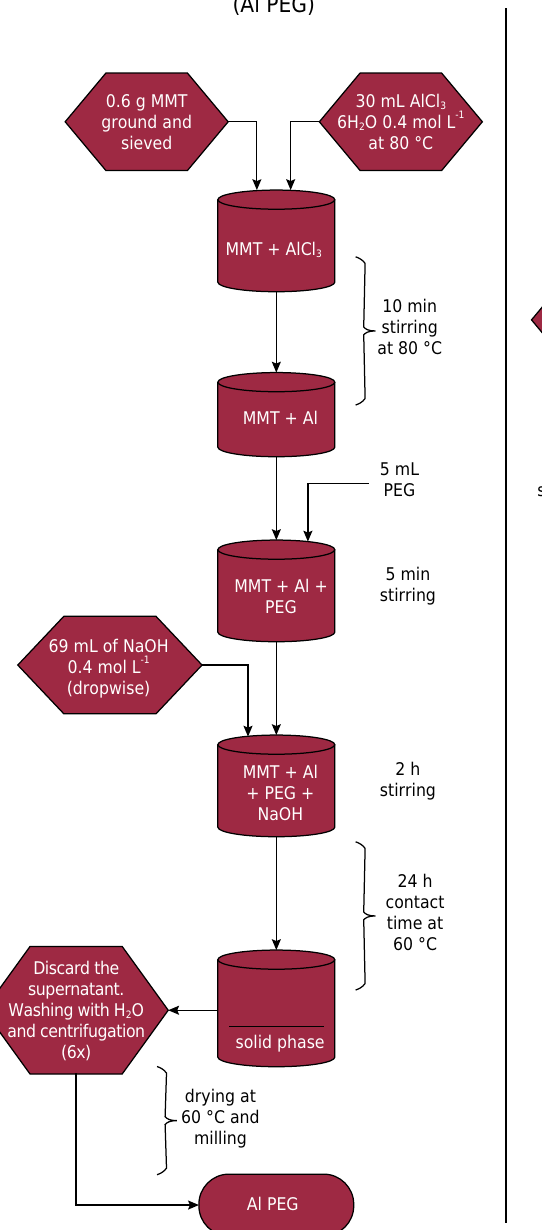
Figure 1. Pillarization processes with and without polyethylene glycol